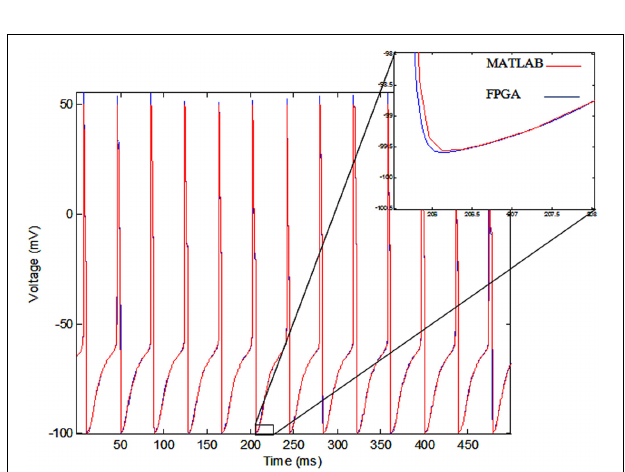
the neurons in E 1 are strongly suppressed by I 1, while I 2 is not able to suppress E 2. Rastergrams of I 1 and I 2 looks almost the same, because both of them are excited by E 1 and E 2 and they receive equal external stimulations. The external currents